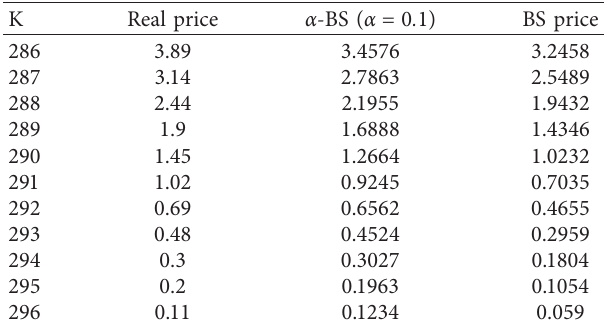
Figure 3: The call option price calibrated by the α -BS model and BS model for different expiration times T . Here, r � 0 . 05, σ � 0 . 8, and S � 10. t Table 1: Price for SPDR S&P500 ETF call option.